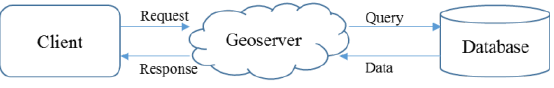
Figure 11. Client Server